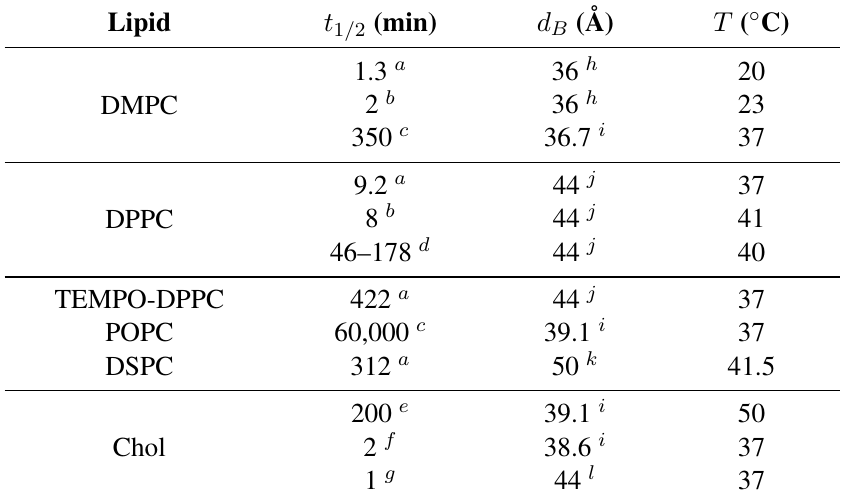
Table 1. Flip/flop half-lives t ( d ) and temperature ( T B